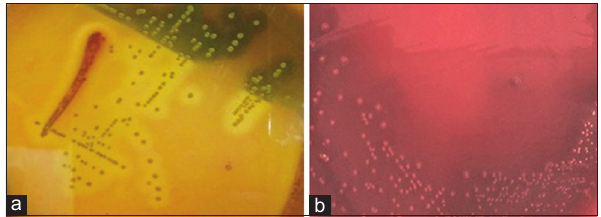
Figure-2: Hemolytic activity of rumen Streptococcus spp. (a) Beta hemolysis of Strain 1 within 18 h, (b) alpha hemolysis of Strain 2 within 18-96